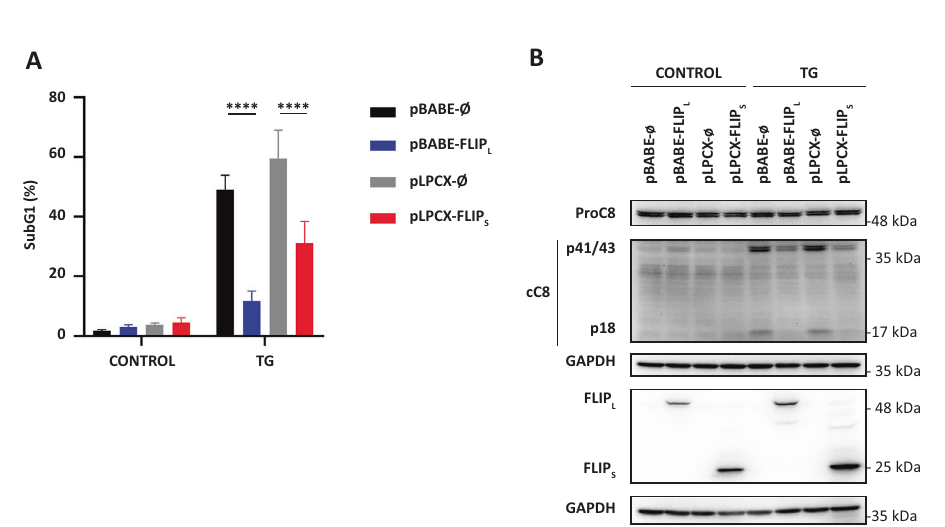
Fig. 3 Effect of ectopic expression of cFLIP on ER stress-induced caspase-8 activation and apoptosis. HCT116 pBABE-ø, pBABE-cFLIP L , pLPCX-ø, and pLPCX-cFLIP S cells were treated or not with TG (100 nM). A Apoptosis was analyzed after 30 h treatment by subG1 analysis as described under Materials and Methods (**** p ≤ 0.0001; two-way ANOVA. Tukey ’ s multiple comparisons test). B cFLIP levels and caspase-8 processing were determined in whole-cell extracts by western blotting after 24-h treatment. GAPDH was used as a protein loading control. Blots are representative of three independent experiments.